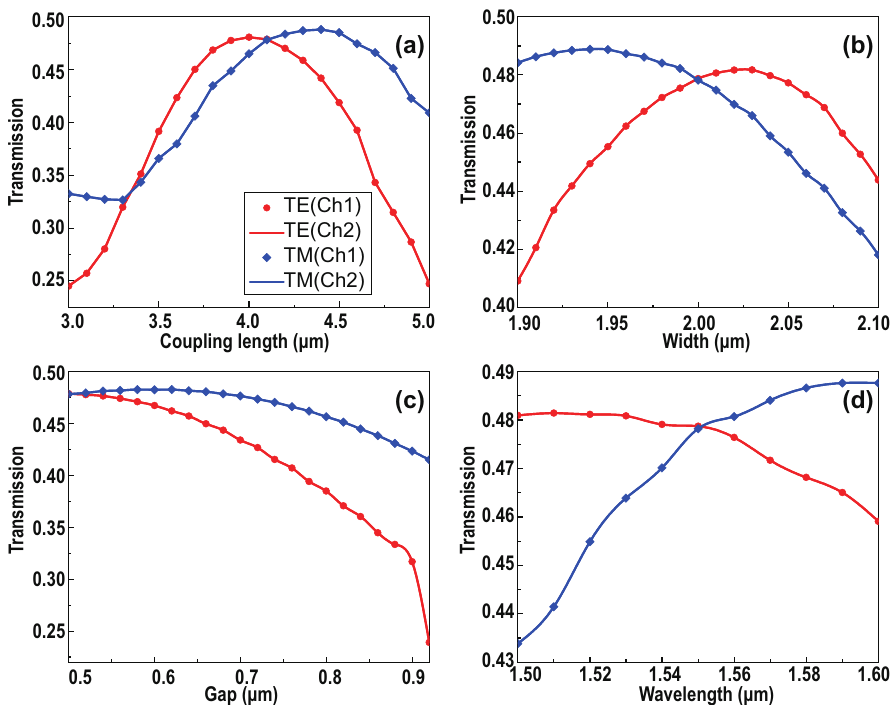
Figure 2. The transmission of the beam splitters versus ( a ) MMI length ( b )MMI width ( c ) MMI gap width of channels ( d ) wavelength. TE polarization at SMW1: red circle; TE polarization at SMW2: red line; TM polarization at SMW1: blue diamond; TM polarization at SMW2: blue